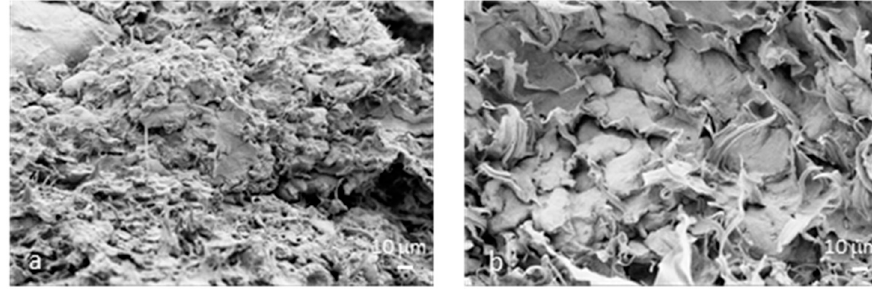
Figure 5. FESEM morphologies of F2_25CL30R ( a ) and F2_25CL120R ( b ) samples.